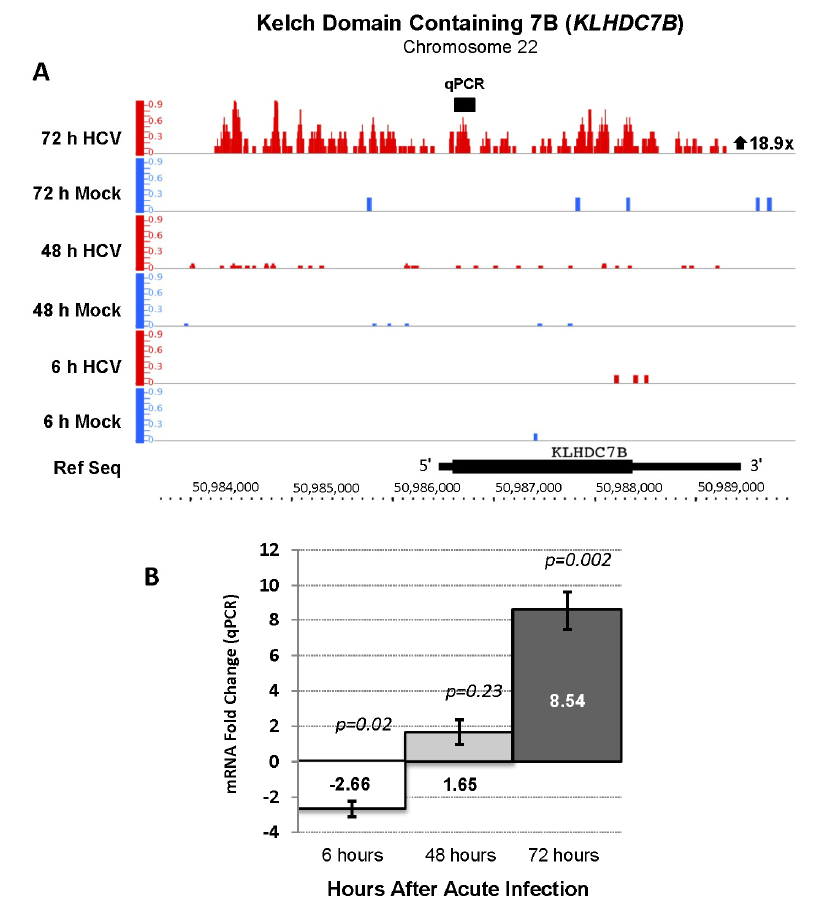
Figure 4. Increased expression of the Kelch domain containing 7B ( KLHDC7B , Chr 22,